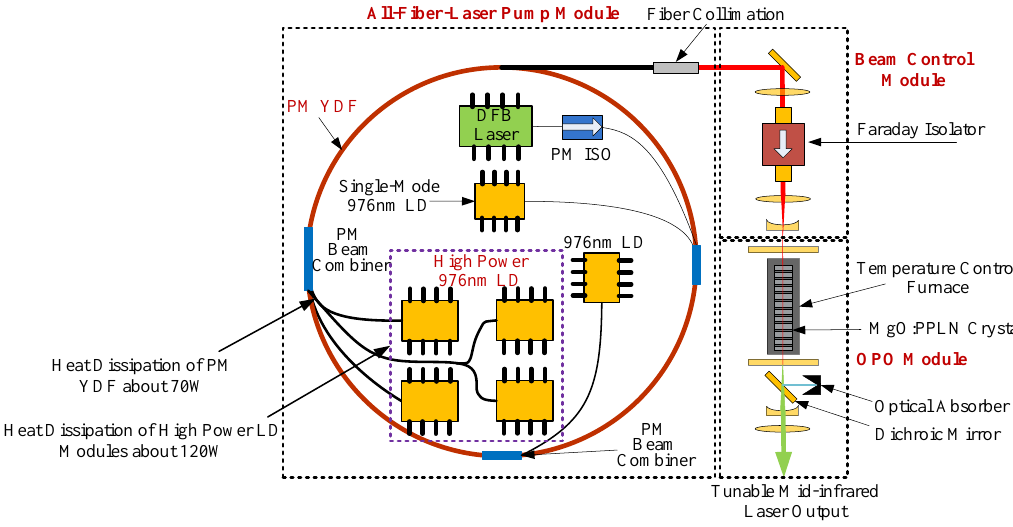
Figure 1. The schematic diagram of the designed tunable all-fiber laser pumped optical parametric oscillator (OPO).